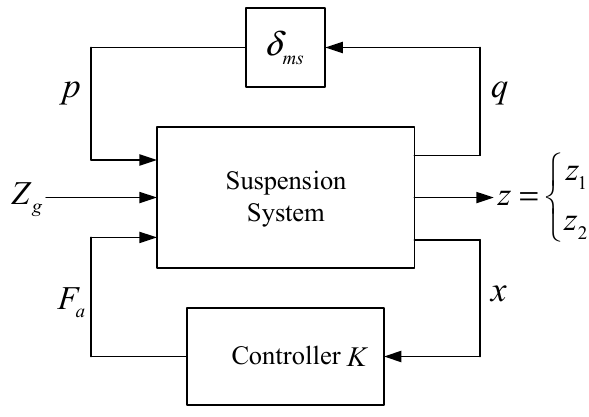
Figure 3. Schematic diagram of controller structure.